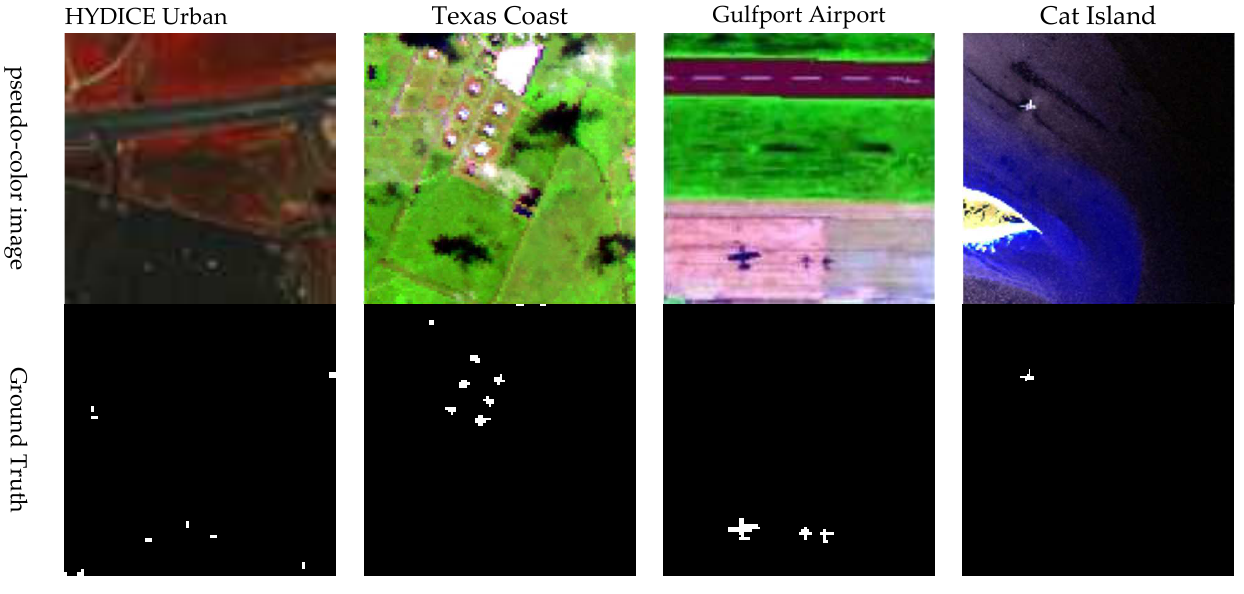
Figure 7. Experimental dataset.